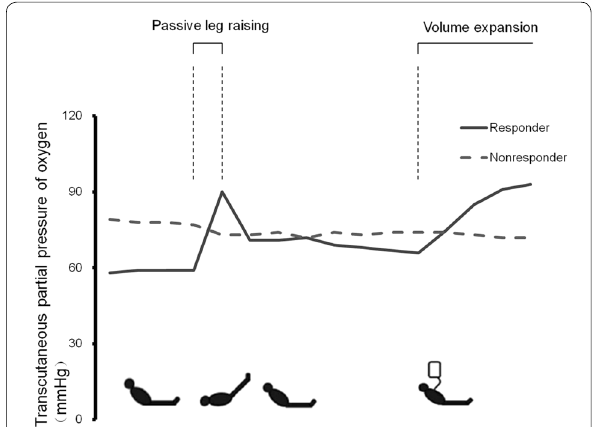
Fig. 1 Typical recording of the transcutaneous partial pressure of oxygen before and during a PLR and then before and after volume expansion in responders and non-responders. PLR, passive leg